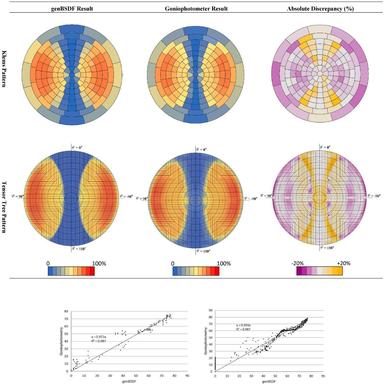
Scatter plot of genBDFG against goniophotometry result for LEF; Klems resolution with 145 values (Left), Tensor tree resolution with 1024 values (Right). Transmission values (%) are correlated with linear regression fit (R2 = 0.987).